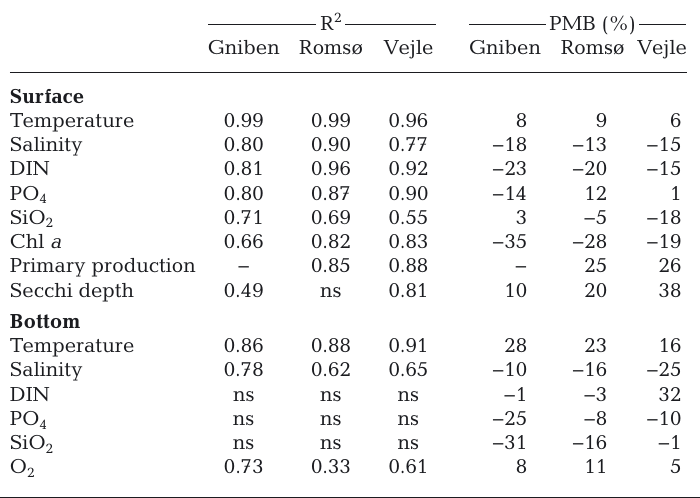
Table 2. Model validation results (R 2 and percentage model bias [PMB])